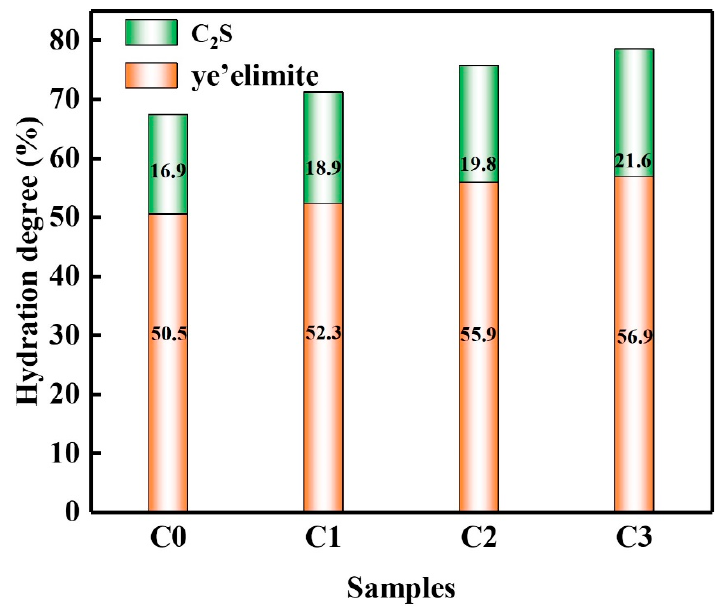
Figure 9. Hydration degree of SAC paste.